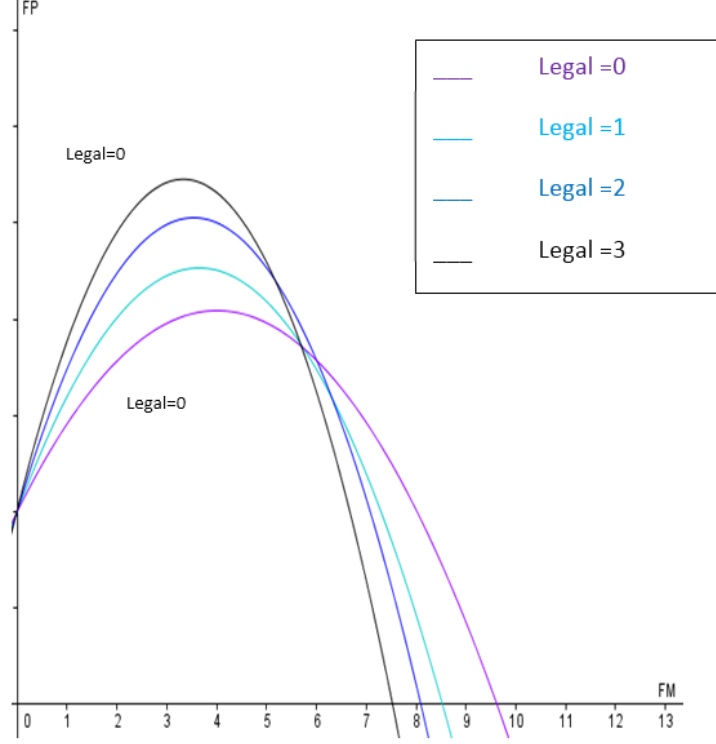
Figure 7. Significant Interactions between Family Management and Legal